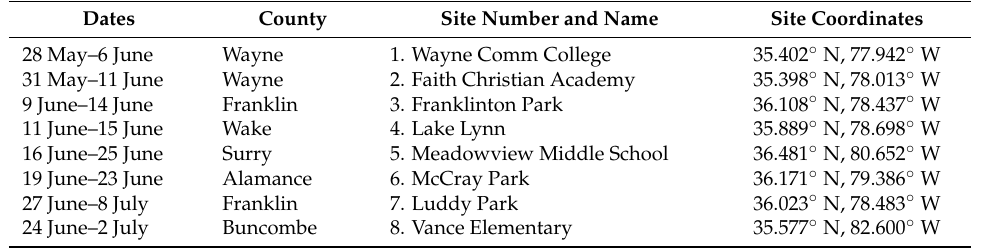
Table 1. North Carolina counties, sites, and dates visited during the 2014 study of Cerceris fumipennis foraging